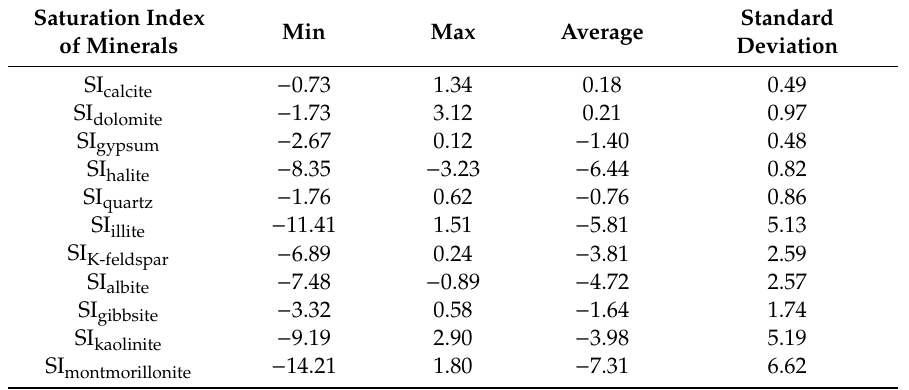
Table 4. Saturation index of minerals (carbonate, gypsum, halite, silicate, and quartz) in groundwater.